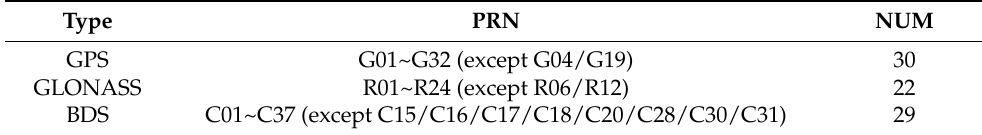
Table 2. GNSS satellites used in the simulation.